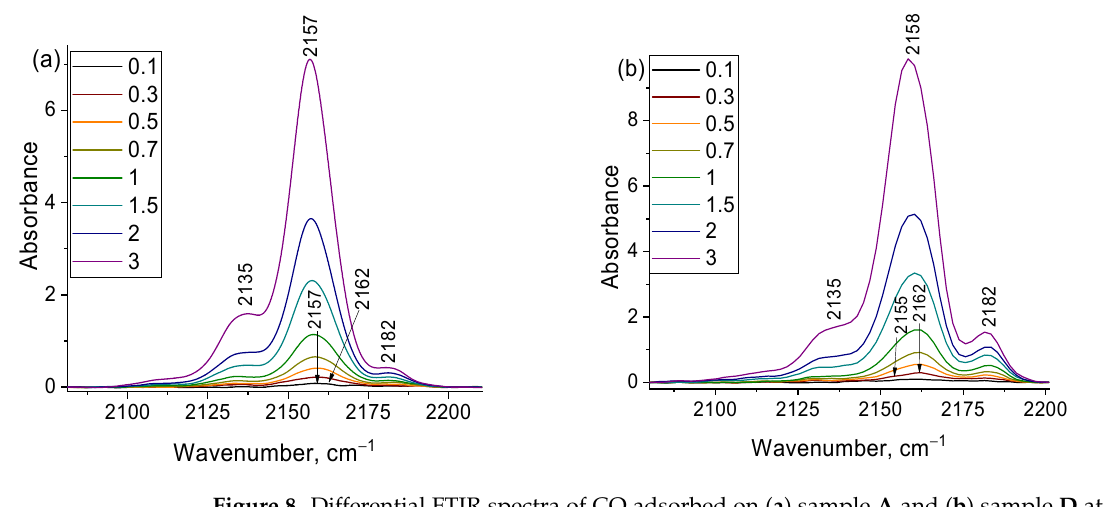
Figure 8. Differential FTIR spectra of CO adsorbed on ( a ) sample A and ( b ) sample D at − 196 °C and a pressure of 0.1–3 Torr.